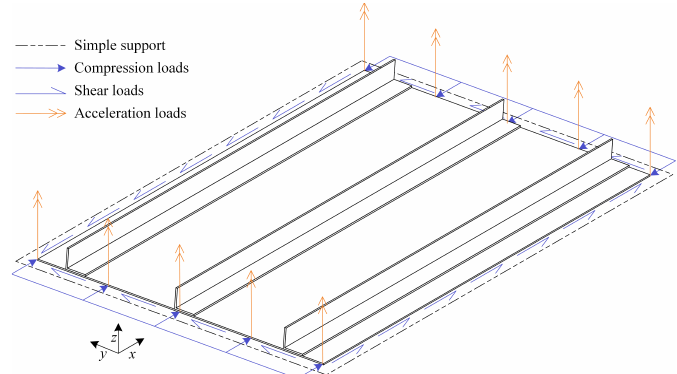
Figure 10. Load cases of stiffened plate. Under the static load case, the stiffened plate is subjected to a uniform compression- shear combined load, in which the axial compression load on the short sides is 30 kN, and the shear load on the four sides is 15 kN, while under the dynamic load case, the short side of the plate is subjected to random foundation acceleration excitation in the z -direction, with a cut-off frequency of [0.1, 1000] Hz and a modal damping of 0.03. The power spectral density (PSD) was estimated using the Welch method based on five sets of random acceleration time-domain load signals, and a standard PSD envelope curve with a root mean square (RMS) of 20 g was established, as shown in Figure